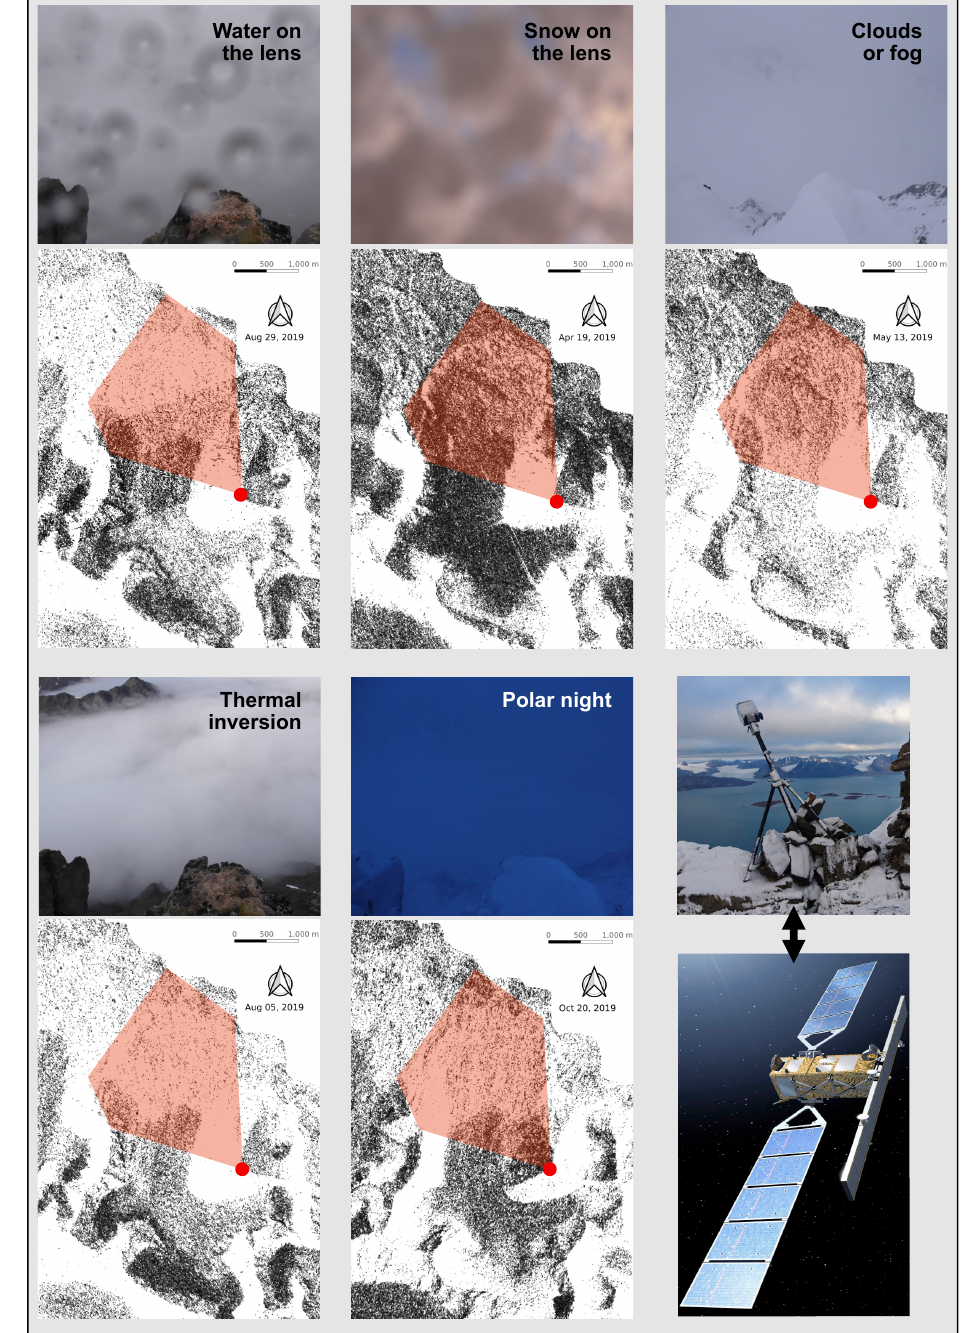
Figure A1. ( Top ): poor weather conditions preventing optical ground-based cameras from collecting pictures, excluding failure to trigger due to exhausted batteries, jammed motor for motorized lenses and microcontroller reset due to electrostatic discharge generated by blown dry snow. ( Bottom ): associated spaceborne RADAR reflectivity maps exhibiting FSC limits as boundaries between bright reflective regions and dark absorbing